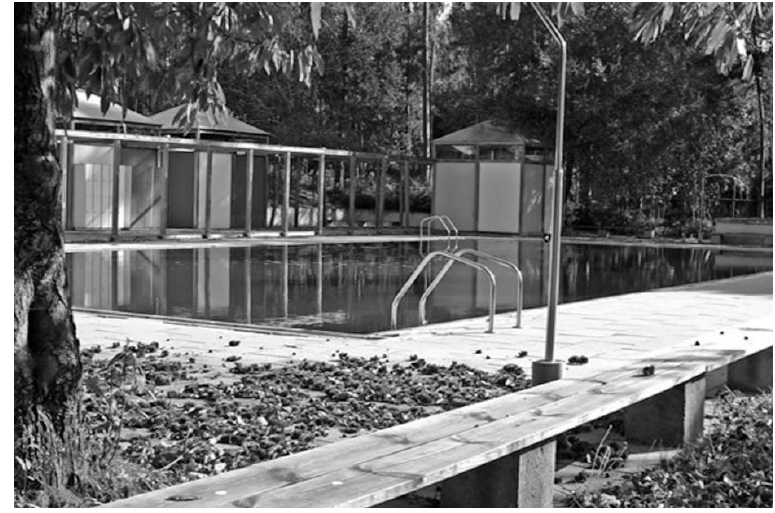
Figure 3. Area of Leisure and Swimming Pools in Cesuras (A Coruña, 1997), by Myriam Goluboff Scheps. Photo credit: mccl arquitectos.